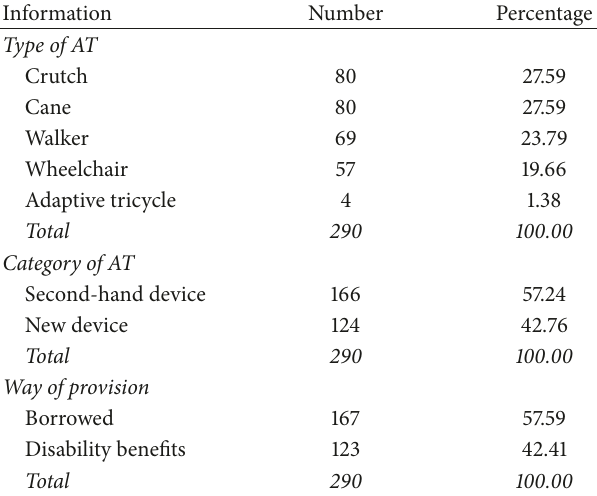
Table 1: AT provision information collected from community hospitals (2015,